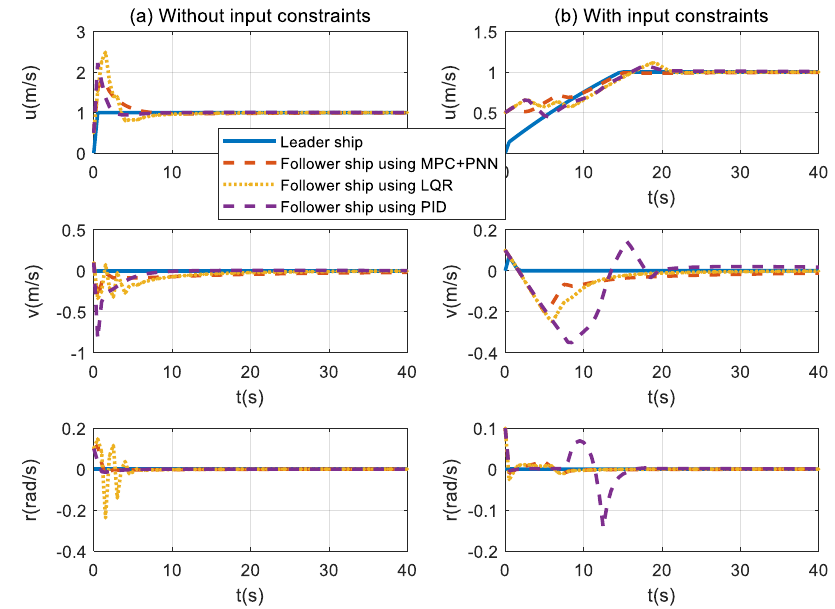
Figure 9. The synchronization of velocities with and without input constraints.